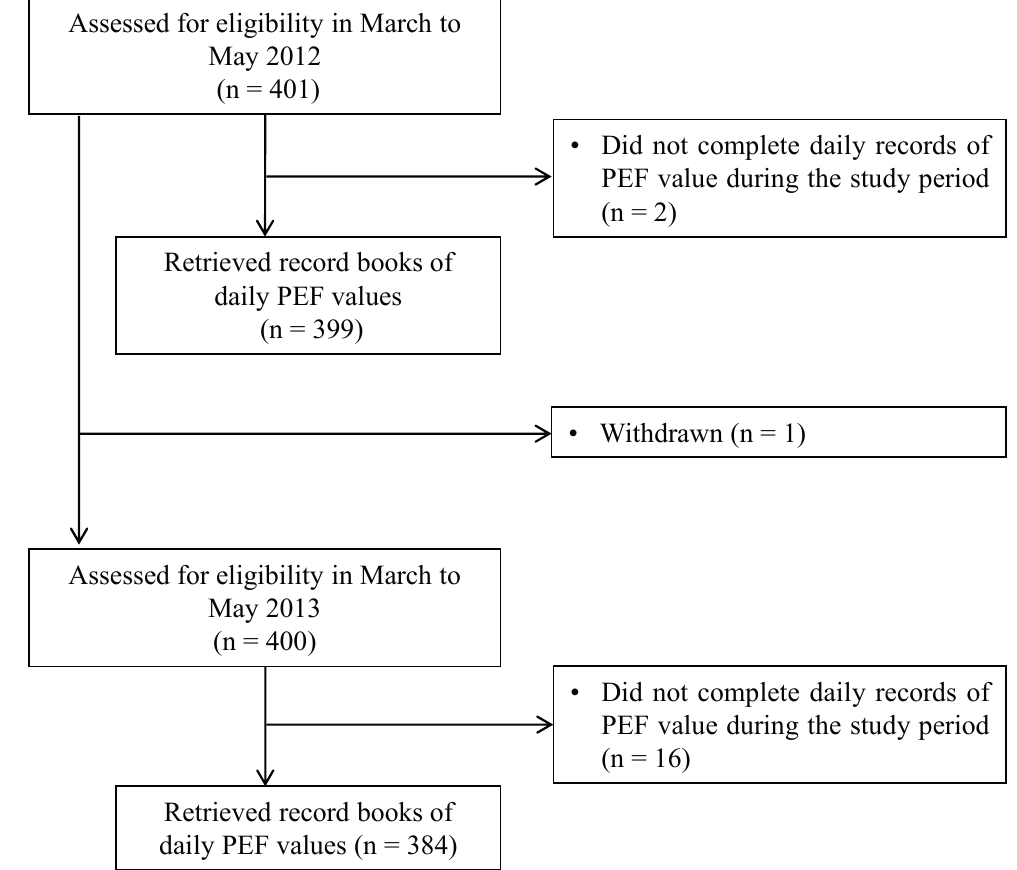
Figure 1. Flow chart showing the recruitment of the children in the